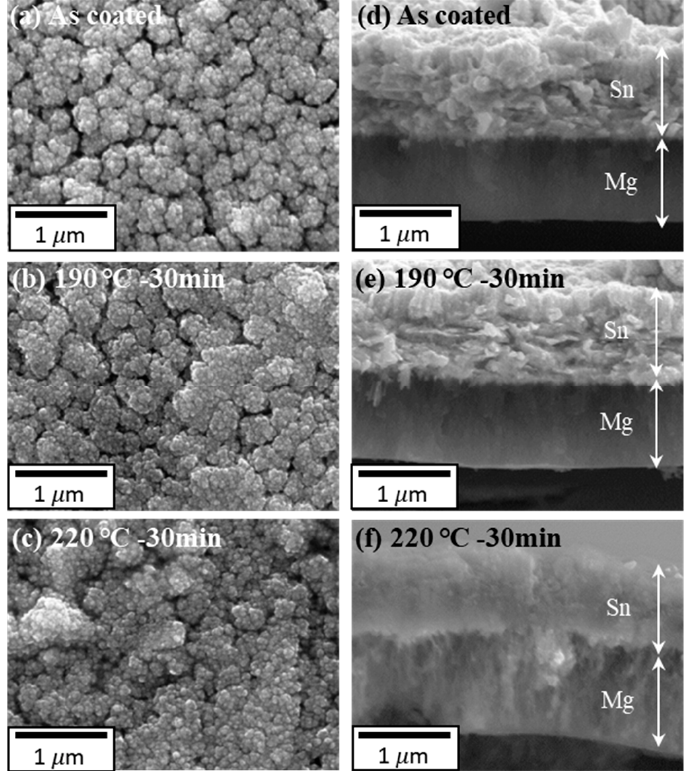
Figure 2. SEM images of Sn/Mg films as a parameter of heat treatment conditions. ( a – c ) Surface images. ( d – f ) Cross-sectional images.